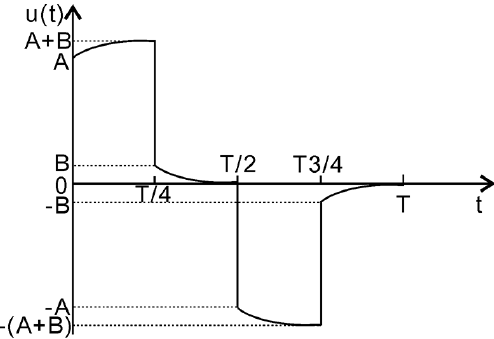
Figure 4. PZNZ waveform from a theoretical simulation.